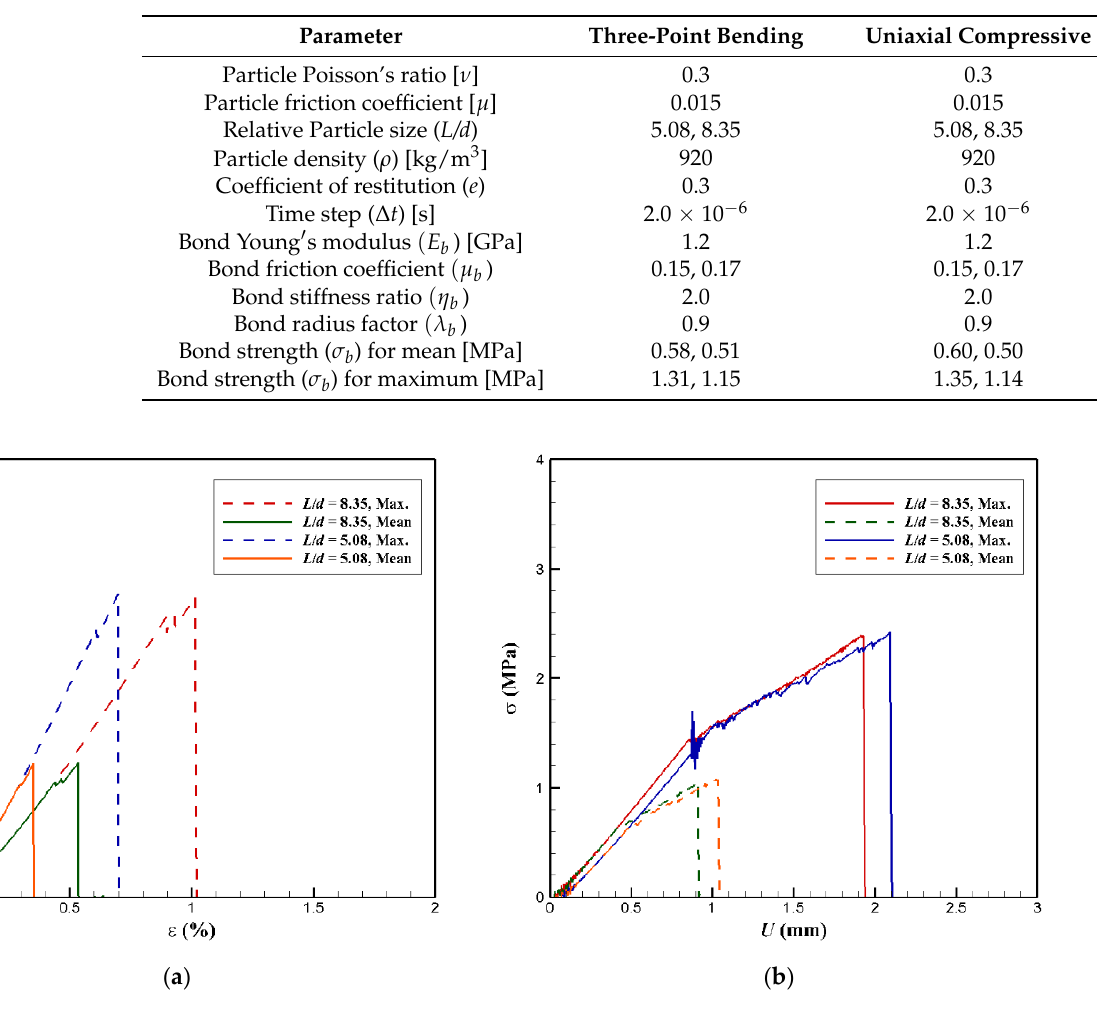
Table 2. Parameters for ice simulation of the Bohai Sea.